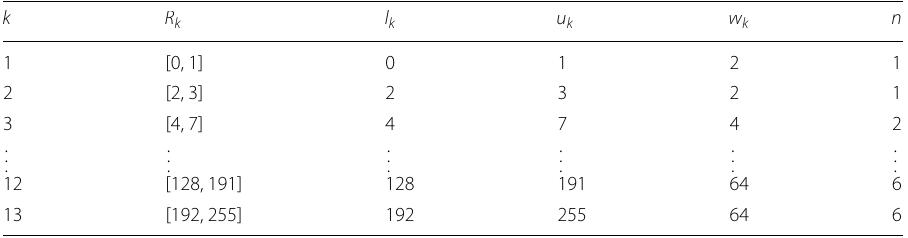
Table 2 Type 2 of the PVD interval classification